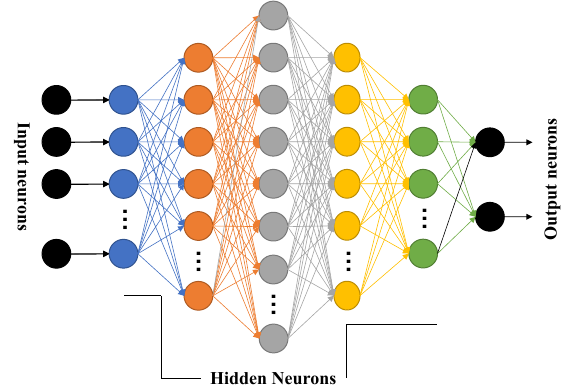
Figure 5. Schematic of the MLP